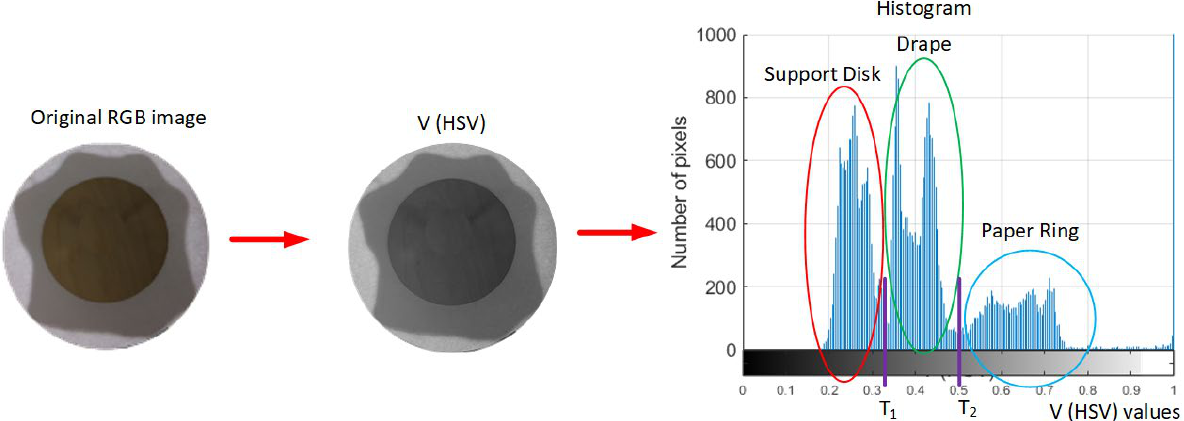
Figure 1. Image processing in Matlab environment.